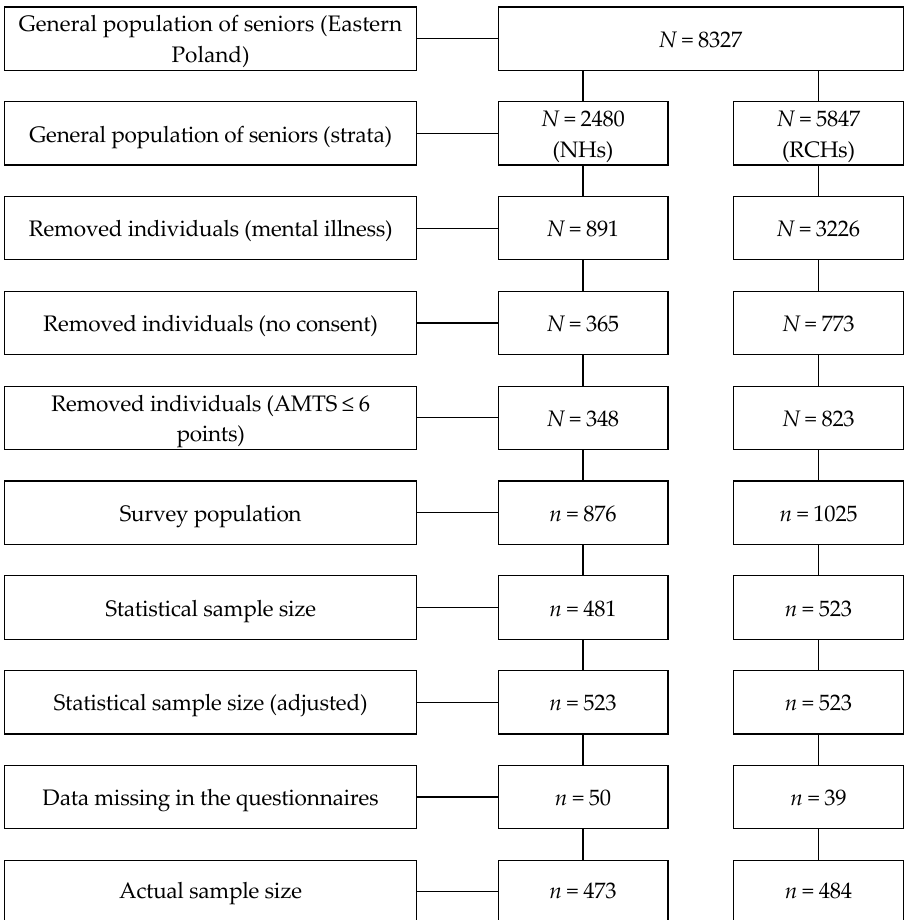
Figure 1. Stages of selection of respondents to participate in the study. Table 1. Basic descriptive